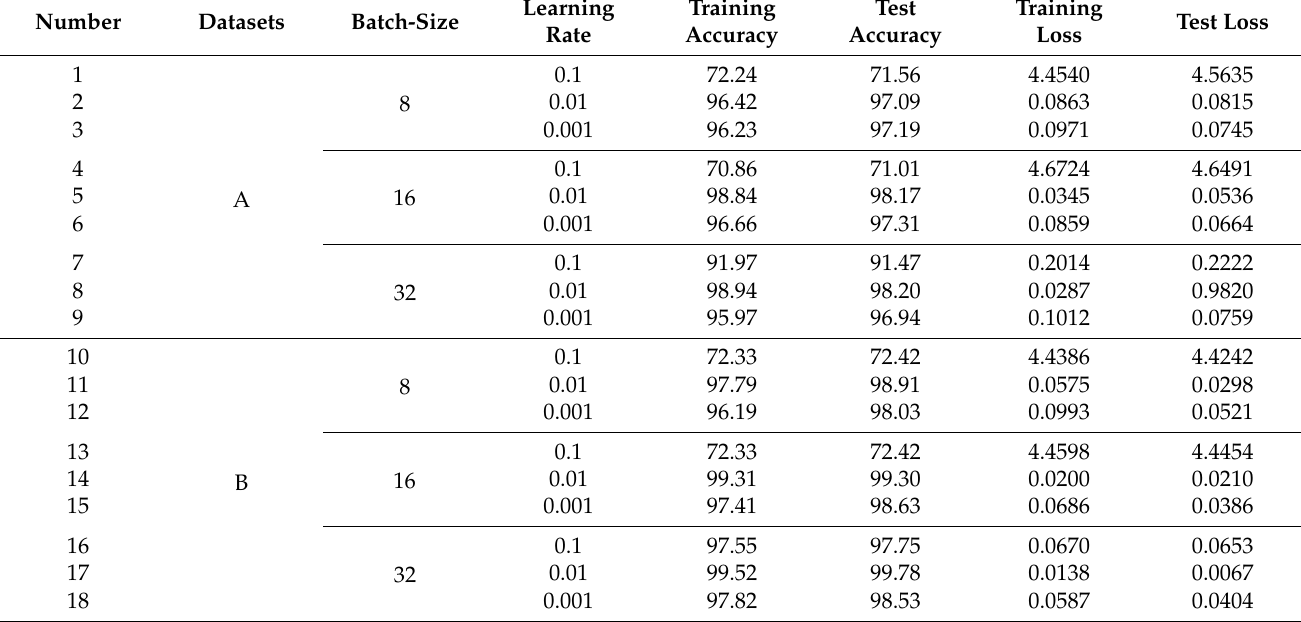
Table 3. Accuracy and loss value of AT-AlexNet model training and testing.